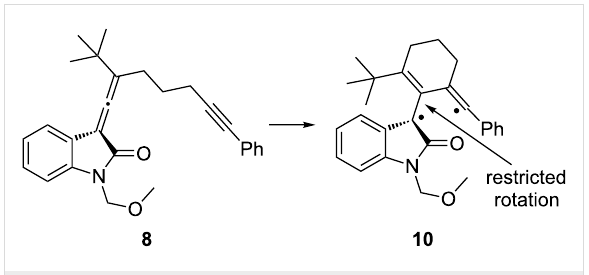
Figure 4: Thermally generated biradical intermediate 10